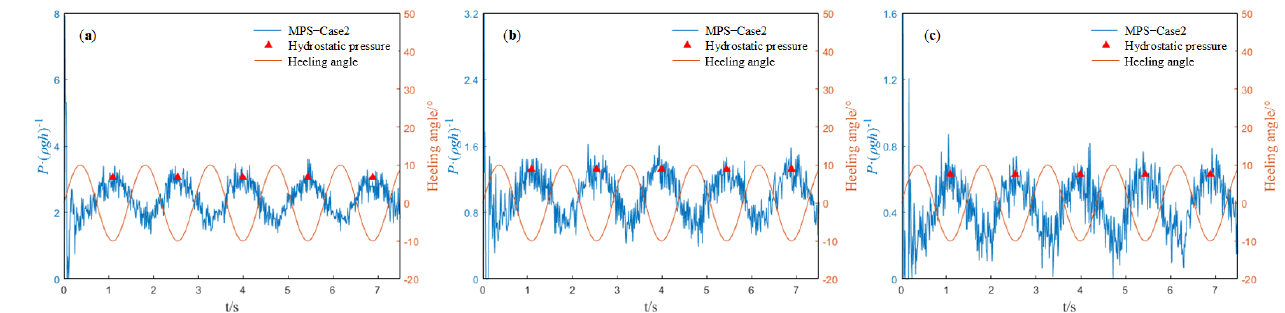
Figure 10. Comparison between hydrostatic and dynamic pressure in case 2 at three probes. ( a ) P 2 ; ( b ) P 3 ; ( c ) P 4